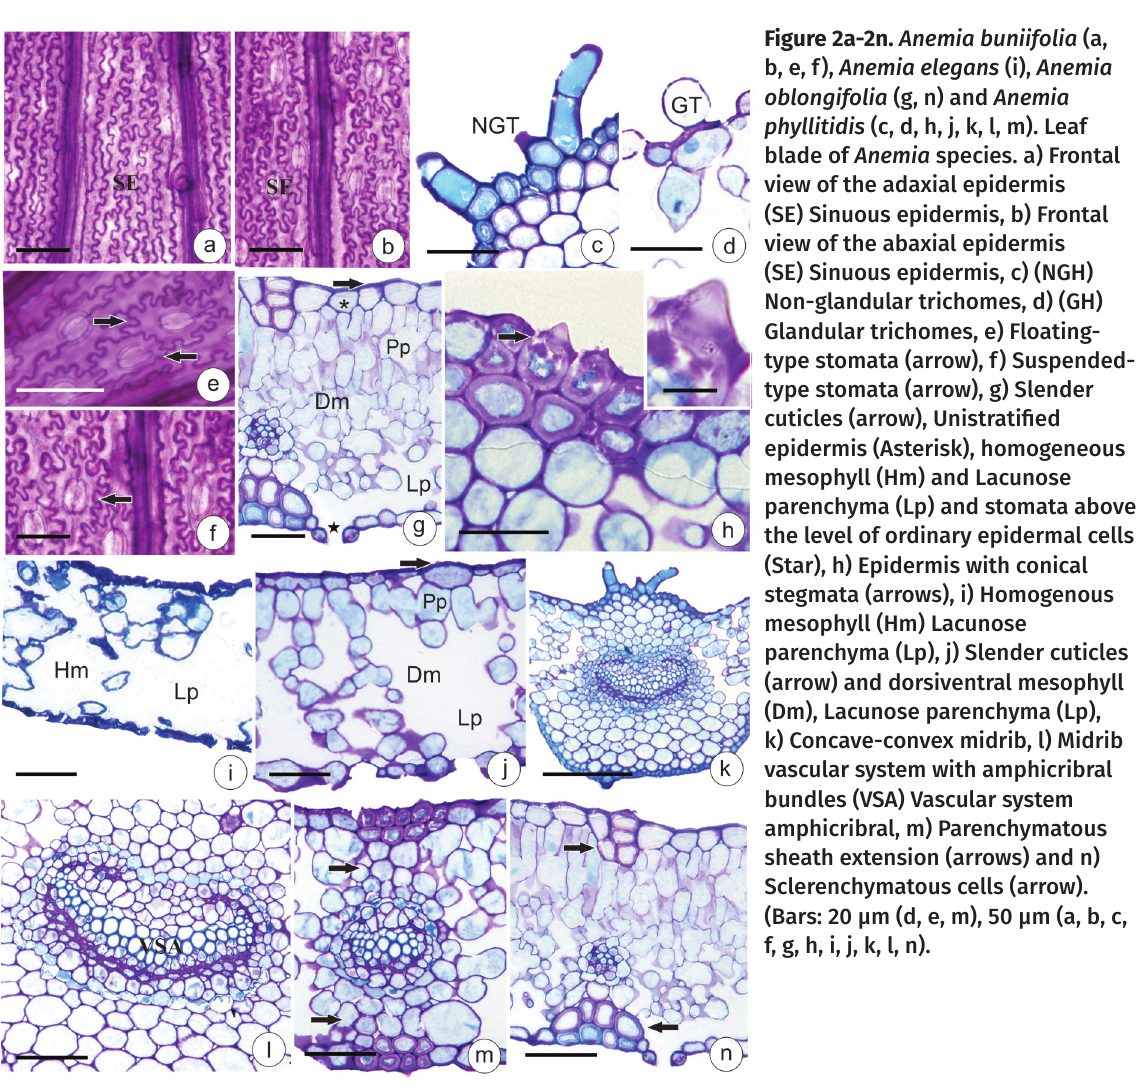
(Fig. 3f-h), starch, and total proteins (Fig. 3k-l) in A. buniifolia, A. oblongifolia, A. presliana, and A.